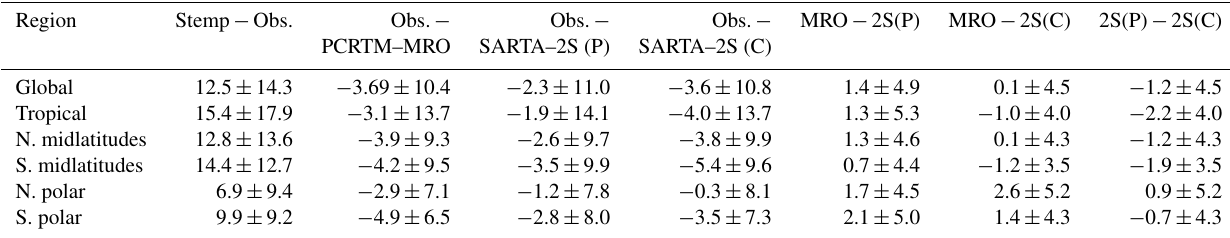
Figure 6. (a) The 1231cm − 1 channel brightness temperatures PDFs (probability distribution functions) for night scenes (global). Locations (1),(2) and (3) highlight large differences that are discussed in the text, while the horizontal lines and associated circles in location (4) represent the BT1231cm − 1 means and standard deviations. (b) Mean biases as a function of scene temperature for various RTAs tested here. Typical standard deviations between the different RTAs are about 10K, while the typical standard deviations between observations and calculations vary from 30K (cold scenes) to 10K (warm scenes). Table 1. Night land and ocean 1231cm − 1 biases for 11 March 2011 in K. “P” and “C” denote the cloud slabs placed at the peak (P) of the weighting function and the cloud profile centroid (C) respectively. Stemp, surface temperature; 2S, TwoSlab. Region Stemp − Obs. Obs.